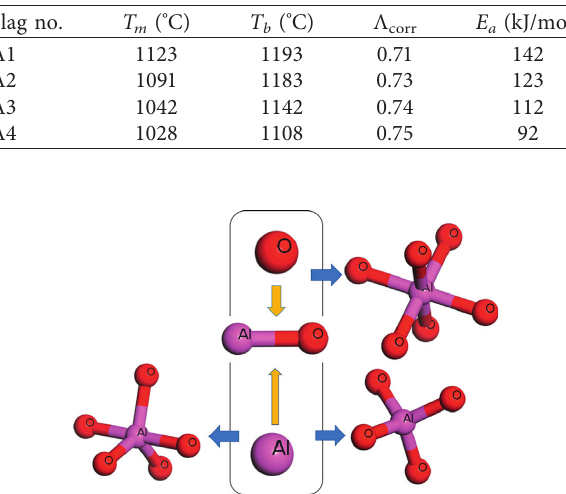
Figure 12: Schematic diagram of the mold flux